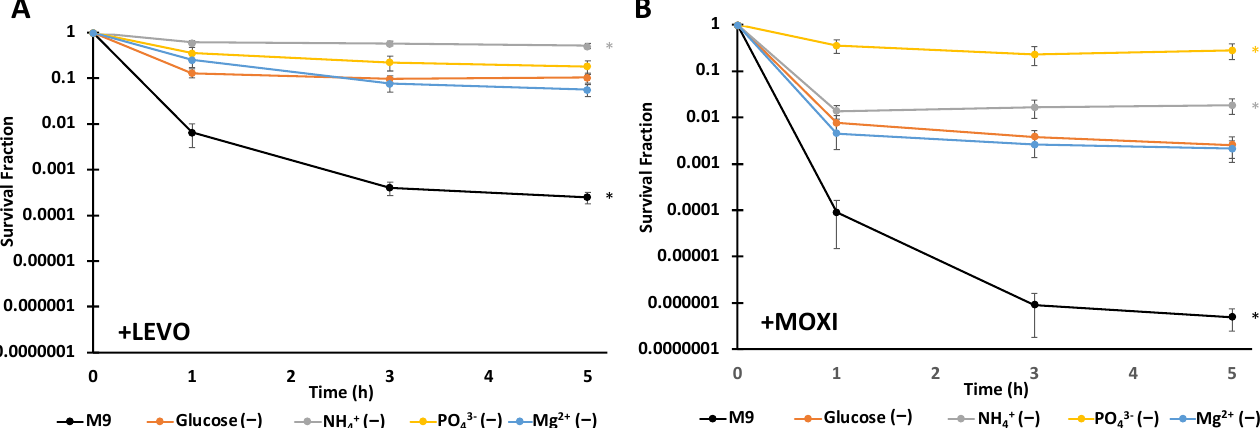
Figure 2. Fluoroquinolone (FQ) persistence levels depend on the type of nutrient starvation and antibiotic used. E. coli cultures that underwent 16 h of starvation for C, N, P, or Mg 2+ and an exponentially-growing control in complete media (M9) were treated with 5 µg/mL levofloxacin (LEVO) ( A ) or 5 µg/mL moxifloxacin (MOXI) ( B ) for 5 h and survival was monitored. Before antibiotic treatment (at 0 h) and at 1, 3 and 5 h after antibiotic treatment, samples were obtained, washed in phosphate buffered saline (PBS) three times, and plated on LB-agar to enumerate colony forming units per milliliter (CFUs/mL). Data points indicate the means of five biological replicates, whereas error bars indicate the standard errors of those means. One-way ANOVA with post-hoc Tukey tests were conducted for each drug treatment to assess significance. ( A ) Complete media samples exhibited a significant difference with starvation samples at 1, 3, and 5 h time points. N-starved samples exhibited a significantly higher rate of survival from C-, P-, and Mg 2+ -starved samples at 3 and 5 h. ( B ) Complete media samples exhibited a significant difference with all starvation samples at 1, 3 and 5 h time points. P-starved samples exhibited a significantly higher rate of survival from C-, N-, and Mg 2+ -starved samples at 1, 3, and 5 h. N-starved samples exhibited a significantly higher rate of survival from C- and Mg 2+ -starved samples at 3 and 5 h time points. * Indicates a significance of p <